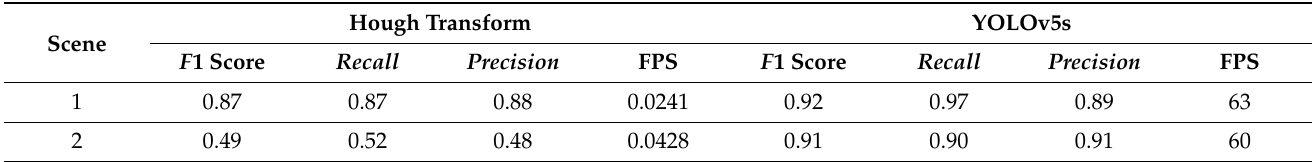
Table 4. Comparison results of Hough transform and YOLOv5s algorithm.